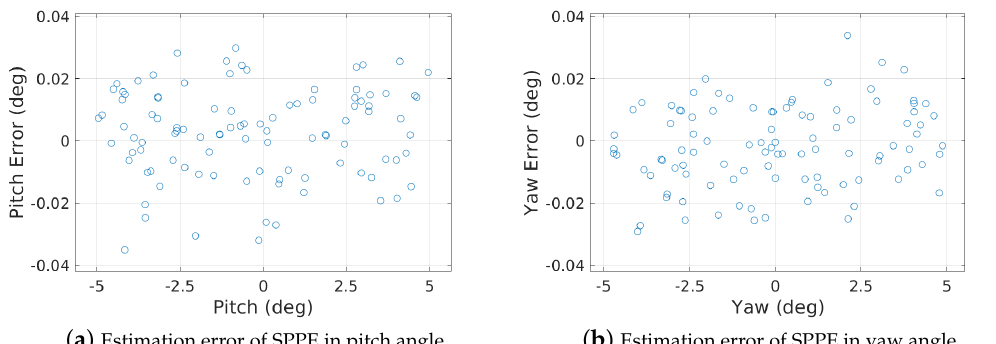
Figure 13. Estimation errors of SPPE in pitch and yaw angles.